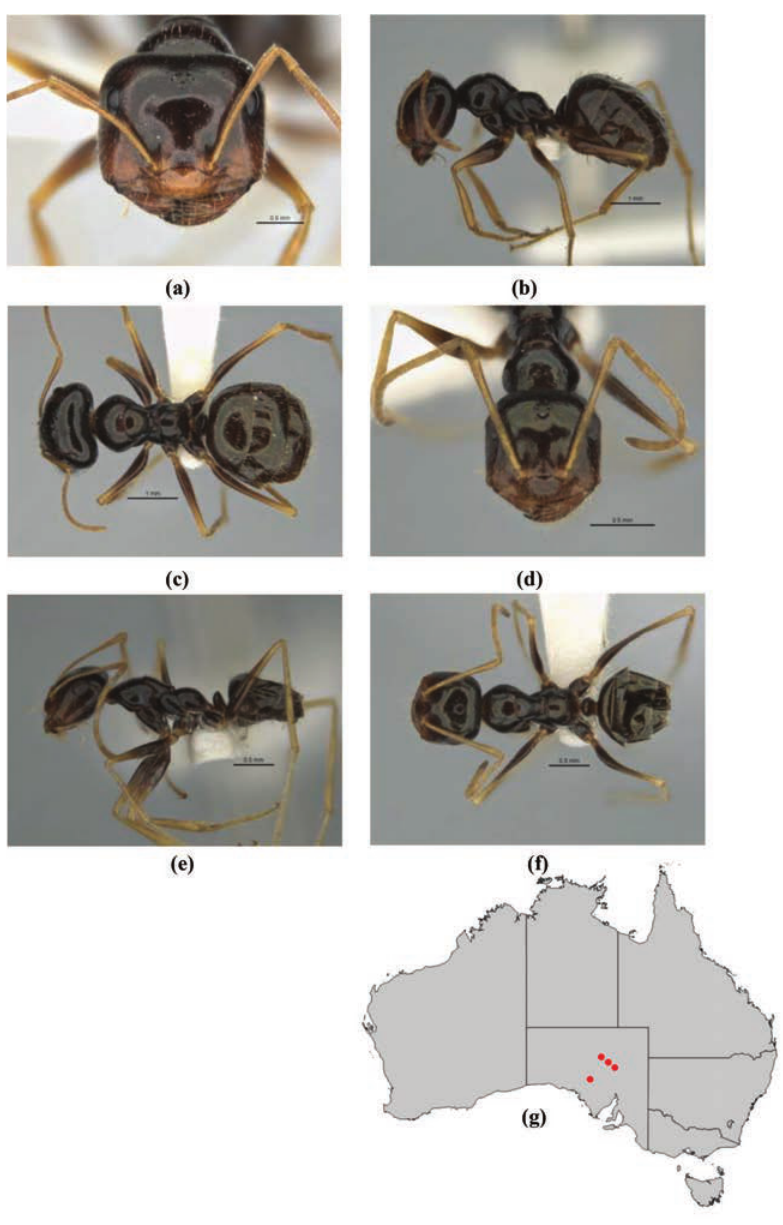
Figure 75. Melophorus oblongiceps sp. n.: major worker paratype (ANIC32-900057–top ant) frons ( a ), profile ( b ) and dorsum ( c ); minor worker holotype (ANIC32-900057–bottom ant) frons ( d ), profile ( e ) and dorsum ( f ); distribution map for the species ( g ). Low resolution scale bars: 1 mm ( b, c ); 0.5 mm ( a, d–f ). Anteromedial clypeal margin broadly and evenly convex; clypeal psammophore set at or just above anterior clypeal margin; palp formula 6,4. Five mandibular teeth in minor worker; mandibles triangular, weakly incurved; third mandibular tooth distinctly shorter than